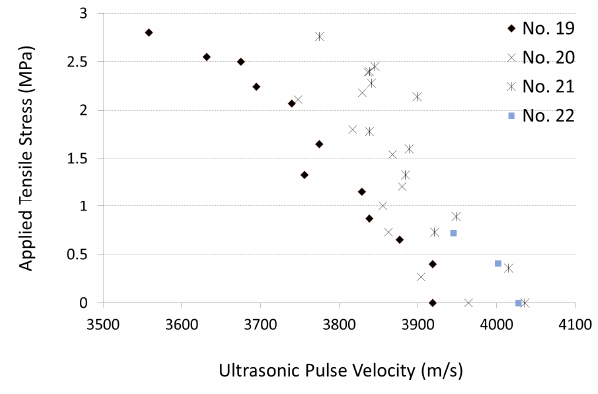
Figure 7. UPV (m / s) vs. applied tensile stress (MPa) for Specimens No. 19 to No. 22.